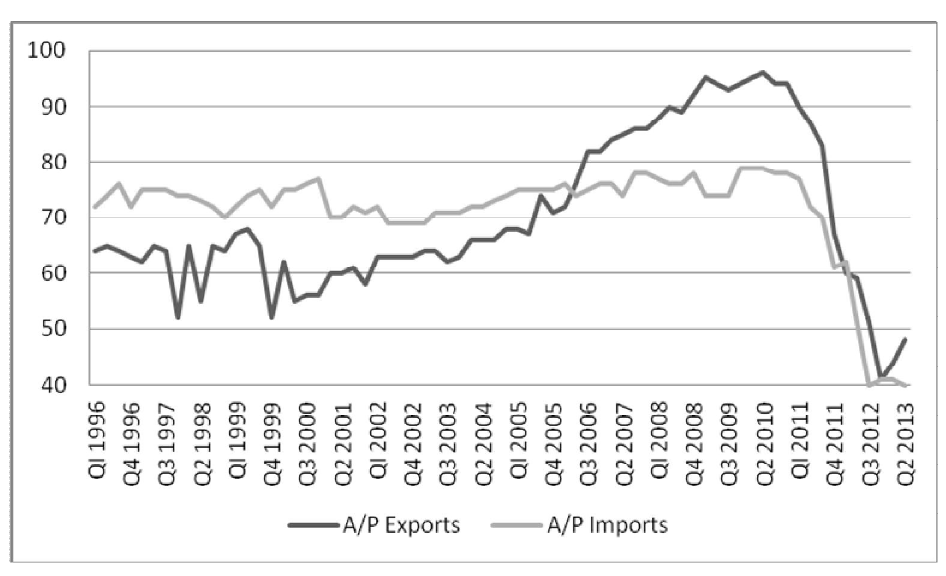
Graph 6: A/P Index for